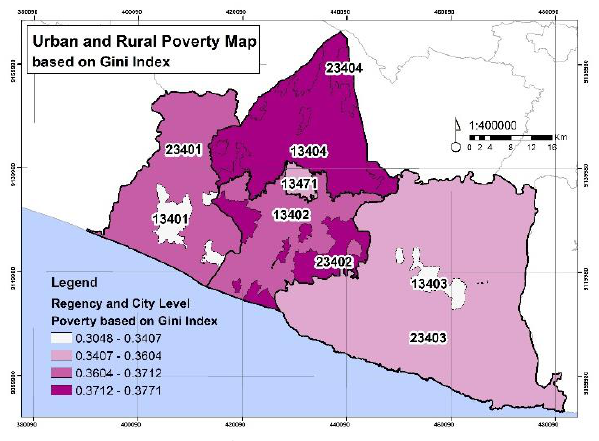
Figure 7. Poverty Map of DIY Province based on Gini index Happiness first classification (0.0624 – 0.0765) based on Gini index shows the area with perfect equality of happiness. The